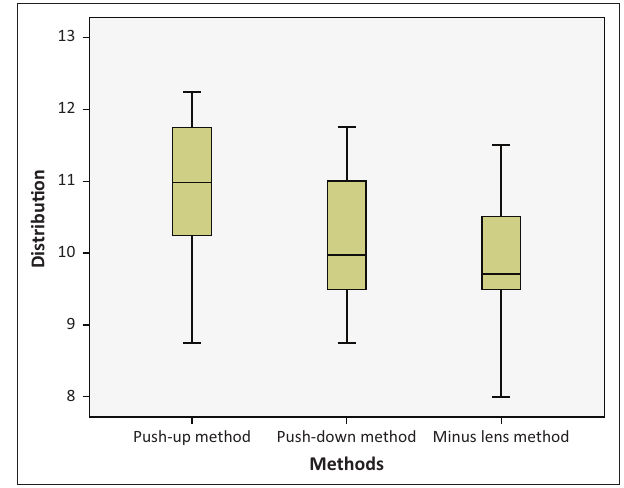
FIGURE 1: Box plots of medians and interquartile ranges representing the measurements of the amplitude of accommodation for the three methods for all subjects. The x -axis represents the methods used to measure the amplitude of accommodation while the y -axis represents the distribution of the measurements of the amplitude of